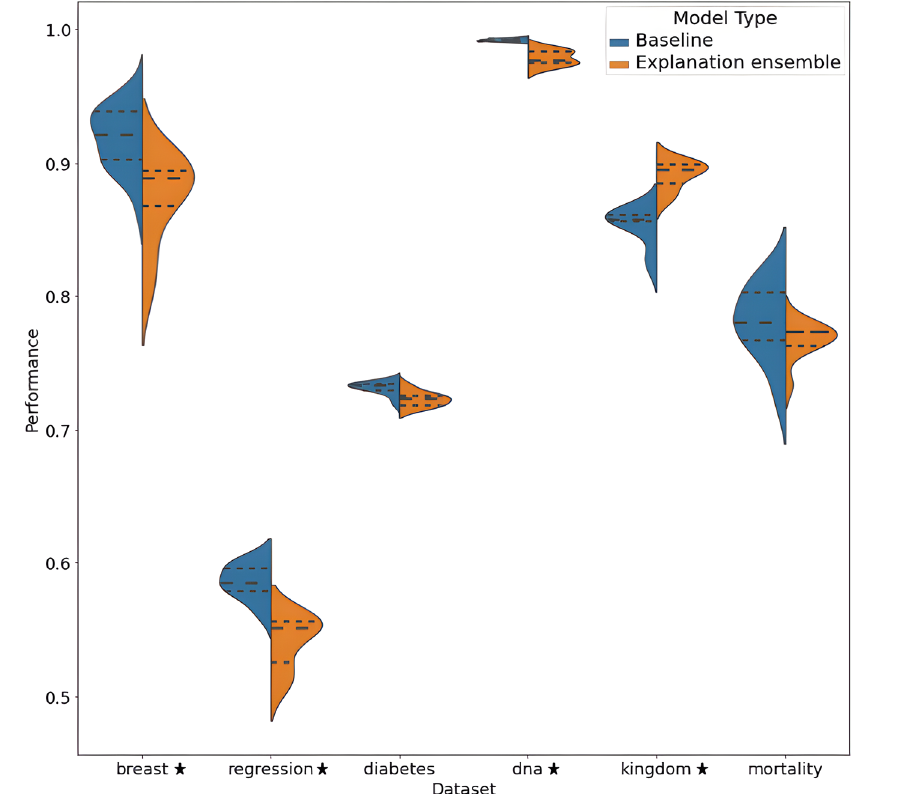
Figure 3. Violin plots showing distribution of model performance across all datasets, for both the base and explanation ensemble architectures. The dashed lines represent the 25th, 50th and 75h quantiles respectively. Performance for the Breast, DNA and Kingdom datasets is measured as accuracy 100 , regression uses AUROC. Stars denote datasets where there is a statistically significant difference in the two architectures, following the results of a Mann-Whitney U test.